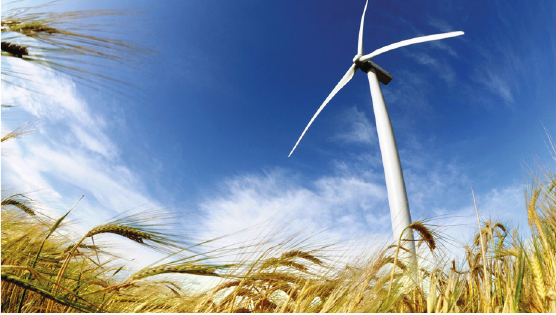
Figure 2: Source of wind energy.